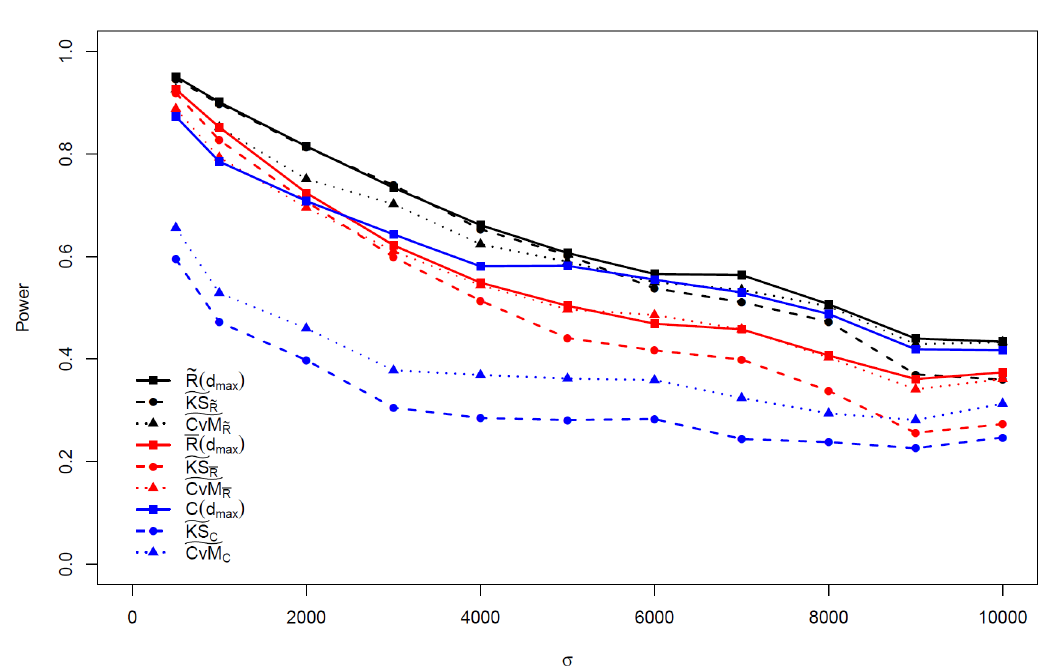
Fig 2. Power performance of statistics related to (cid:22) R ð d Þ , ~ R ð d Þ , and C ( d )under alternative hypothesis (1) with parameter μ 375. Only maximum powers of (cid:22) R ð d Þ , ~ R ð d Þ , and C ( d )over values of d considered are displayed; d max refers to the value of d yielding the largest power.